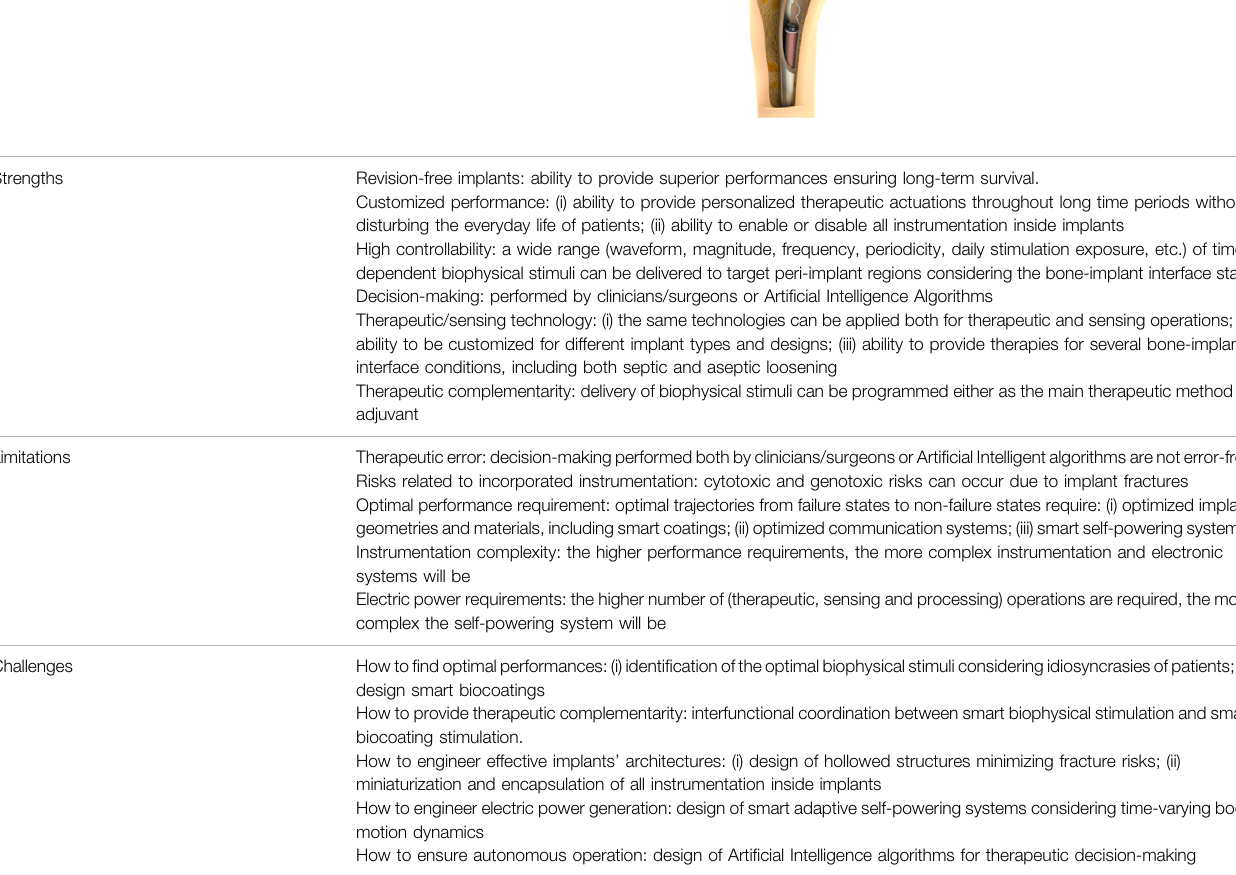
TABLE 1 | Overview of the main strengths and limitations of multifunctional smart implants as hybrid technologies, as well as the main challenges to their effective development. Analyses